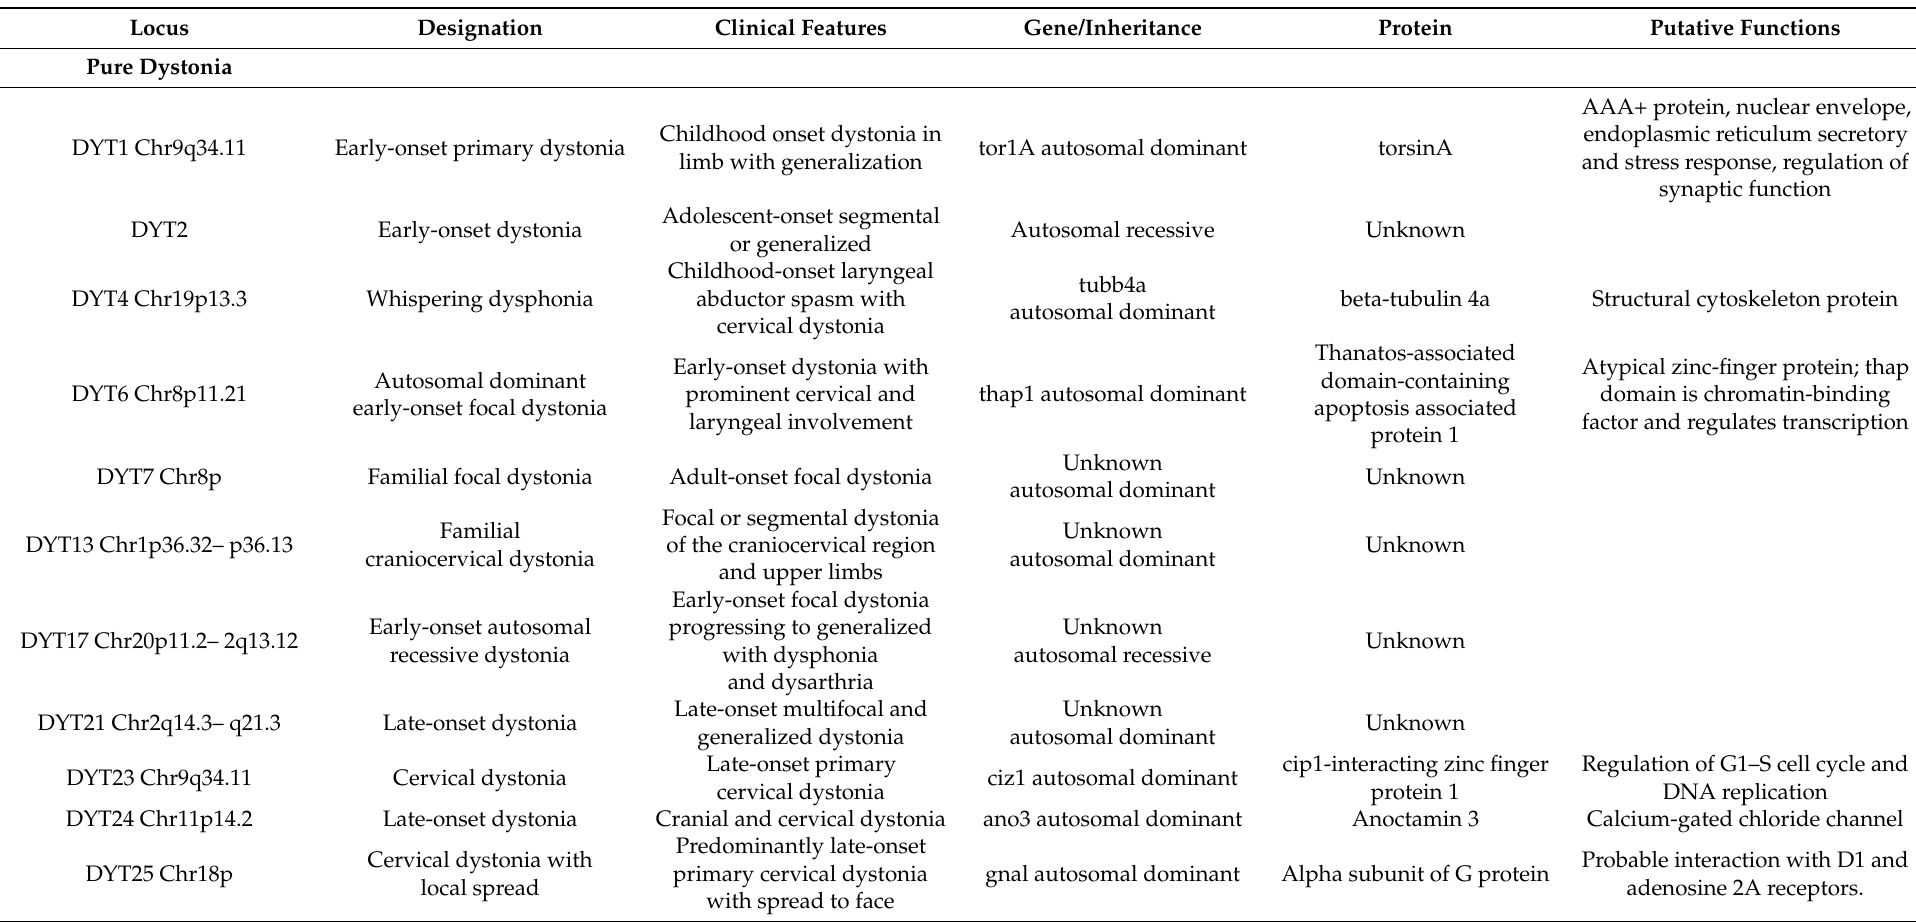
Table 1. Summary of genes and proteins involved in the genetic forms of primary dystonia and dystonia syndromes. Adapted and reproduced with permission from